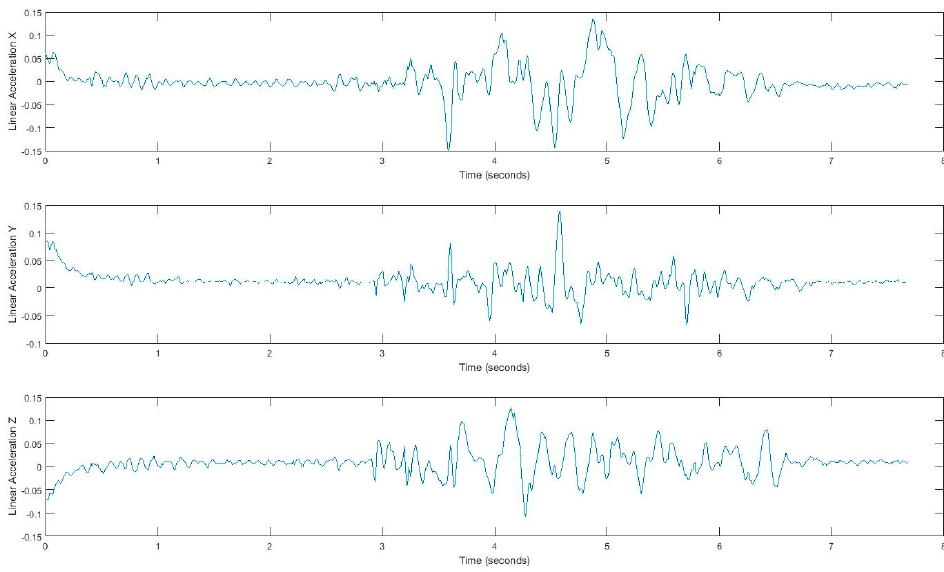
Figure 2. Tandem gait linear acceleration signal.